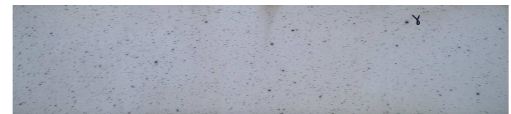
Figure 4: Example of digitized film from SAO Baker– Nunn camera The corrected spectral image is then projected down to a 31-inch f/1 spherical primary mirror. The focusing converging image was then reflected back up to a 4-inch x 6-inch x 0.6-inch thick mosaic of fiber-optics making film supporting focusing plate. The resulting database is expected to has applications in astronomy as